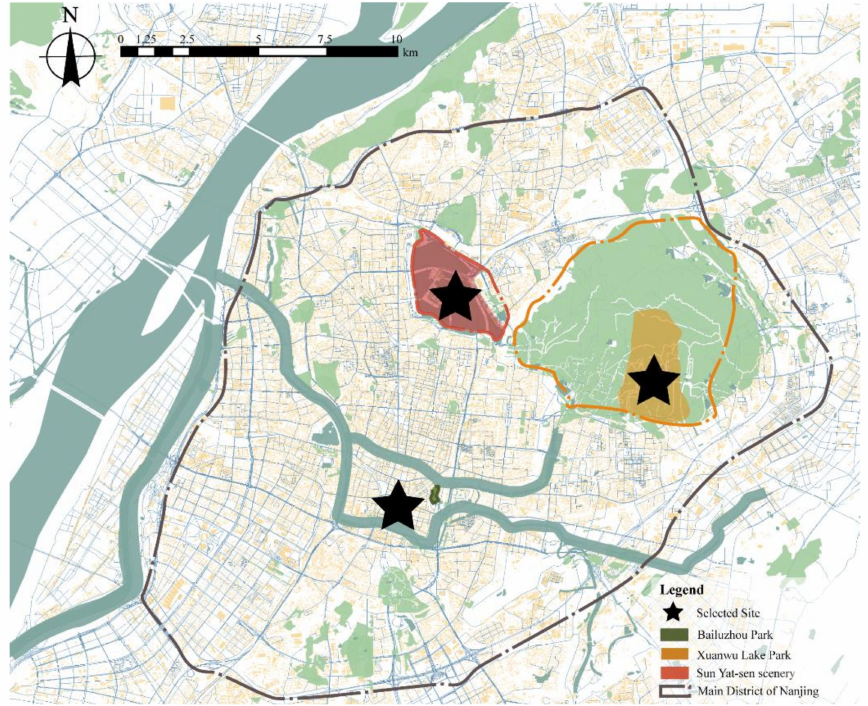
Figure 1. Site selection in downtown Nanjing. Copyright 2020 © Author, all rights reserved, used by